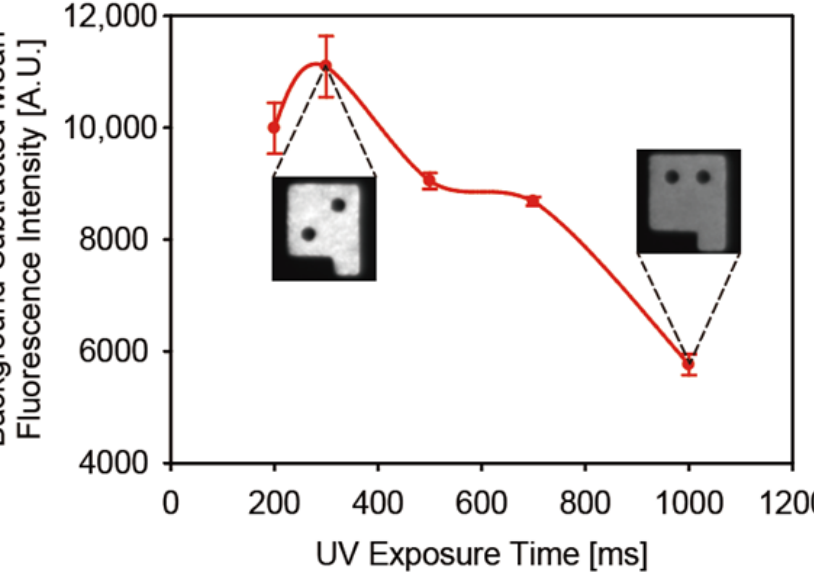
Figure 3. Probe loading densities in microparticles depending on UV exposure